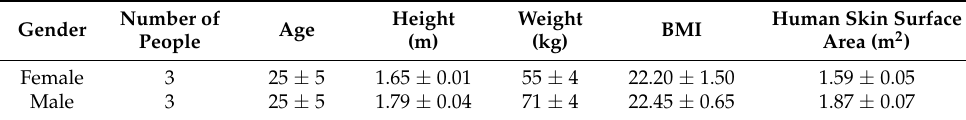
Table 1. Statistical information of participants in the